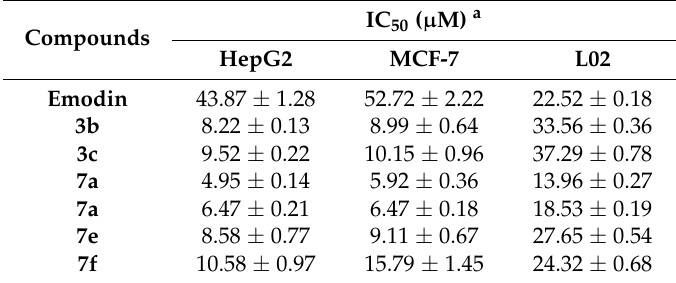
Table 4. Anti-proliferative activities of several more active compounds. Compounds